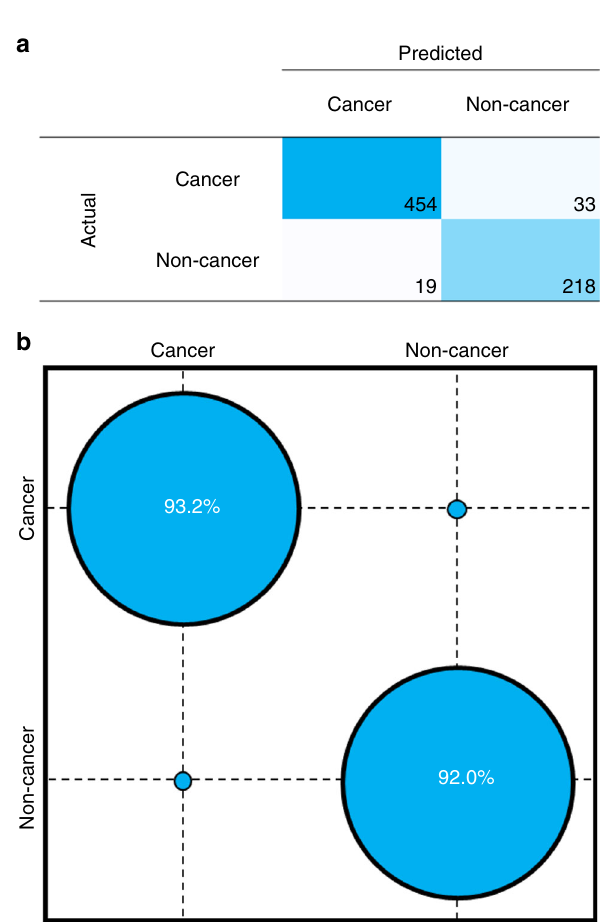
Fig. 5 Disease prediction of blood serum using ATR-FTIR spectroscopy coupled with SVM classi fi cation. a Confusion matrix of classi fi cation on a per patient basis with b confusion ball visualisation of sensitivity and speci fi city. All data refer to resampled and averaged test set